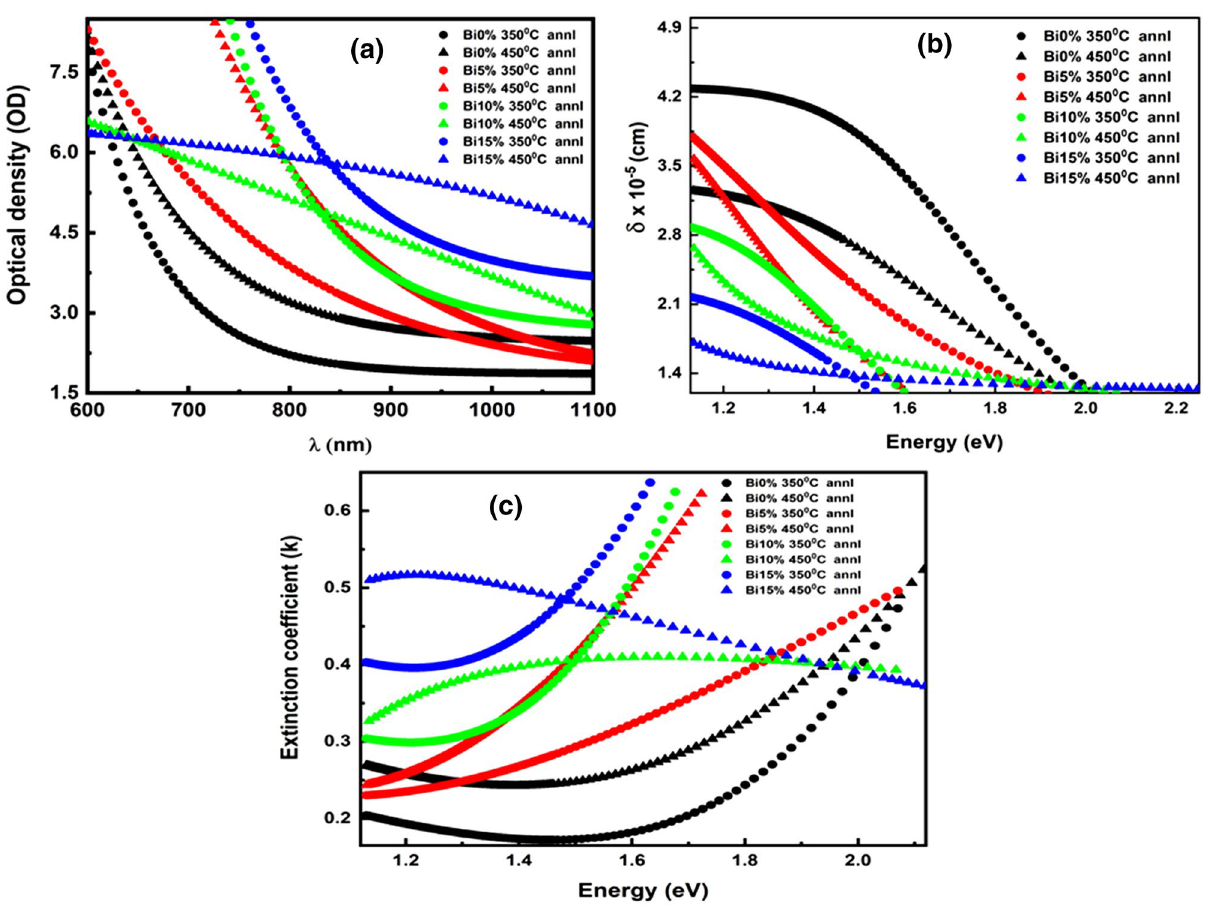
Figure 6. ( a ) Optical density, ( b ) skin depth, ( c ) extinction coefficient spectra for the annealed Bi x In 35-x Se 65